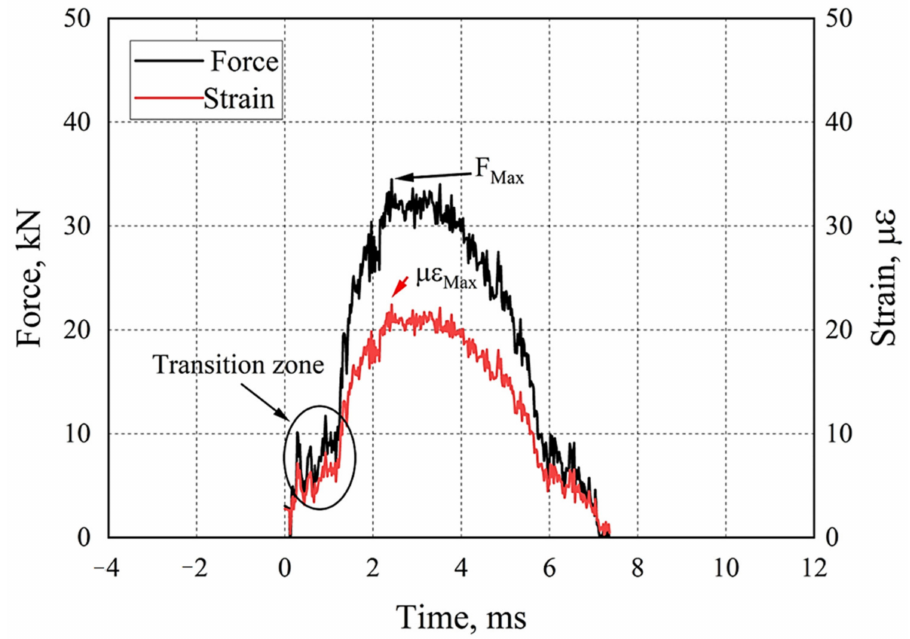
Figure 18. Strain vs. time and force vs. time behavior of dissimilar welding during the impact